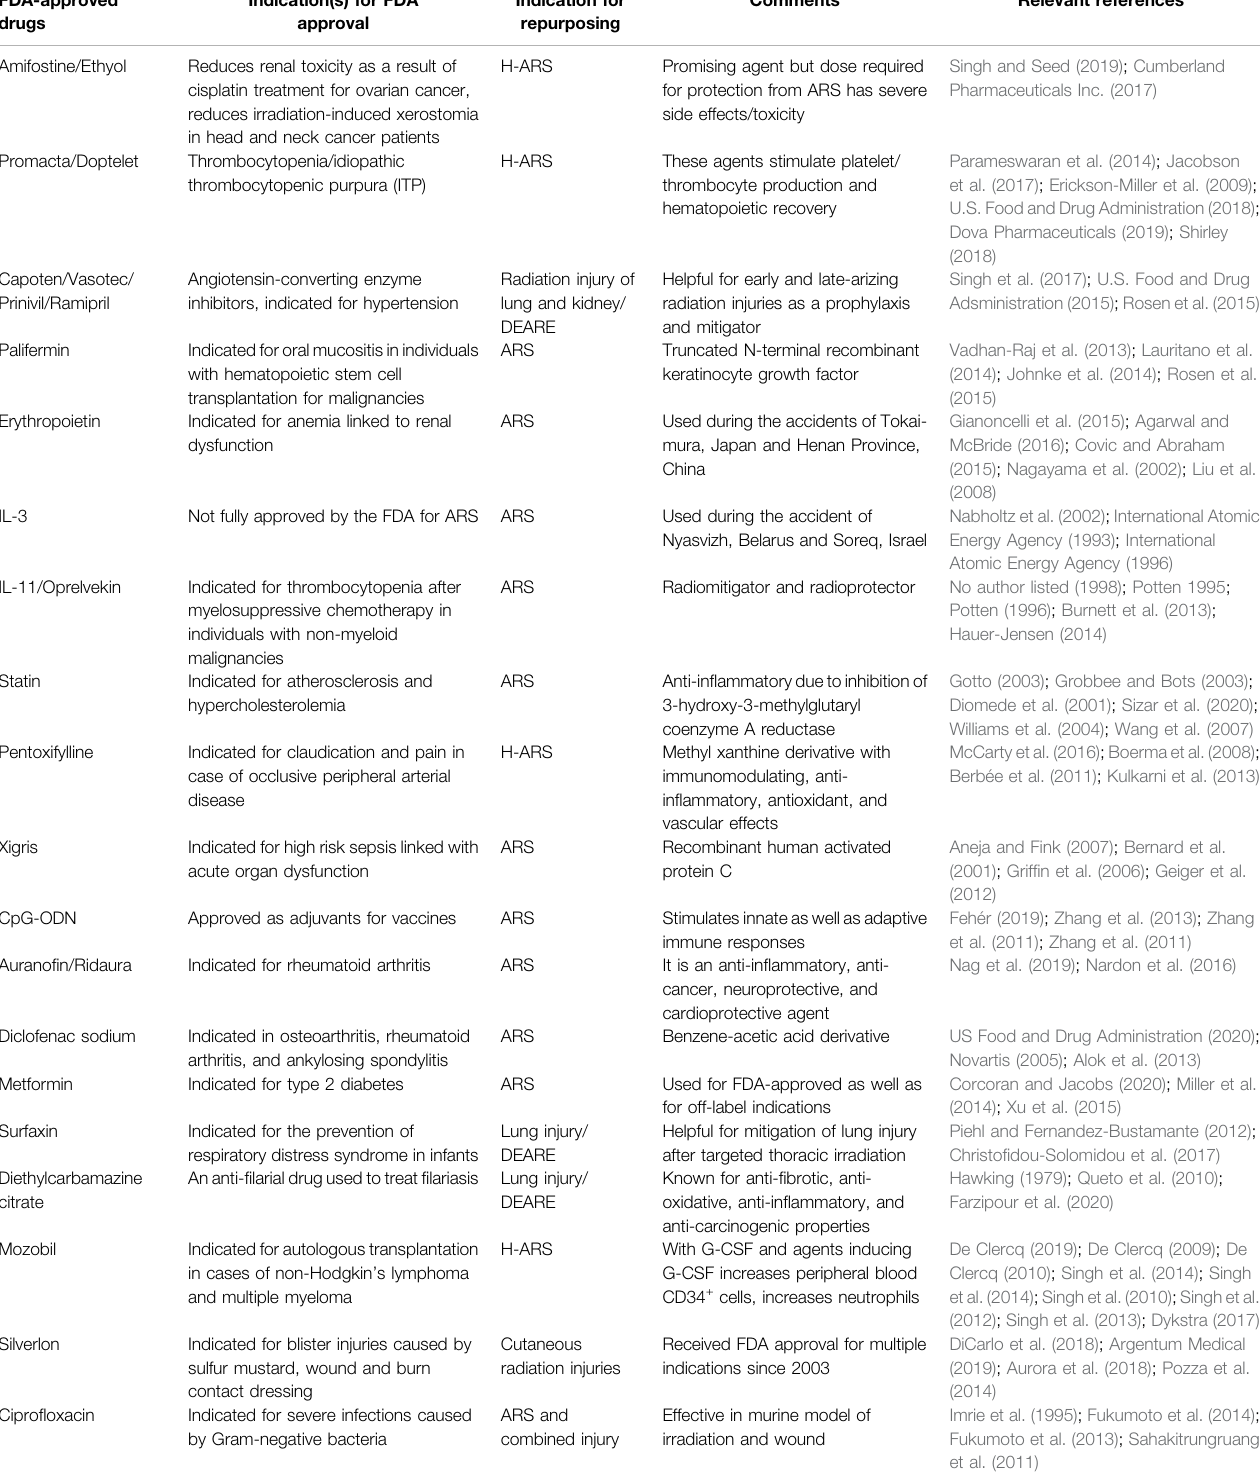
TABLE 2 | US FDA-approved drugs for other indications currently being investigated for repurposing for acute and delayed effects of radiation